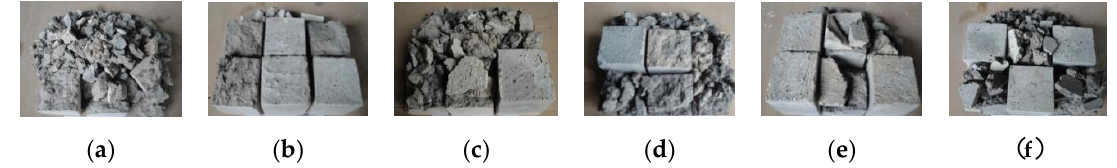
Figure 12. Morphology of UHSC with various steel fibers after subjected to a temperature of 800 ◦ C. ( a ) Plain/UHPC; ( b ) SF1/UHPC; ( c ) SF2/UHPC; ( d ) SF3/UHPC; ( e ) RSF/UHPC; ( f ) RSFR/UHPC.